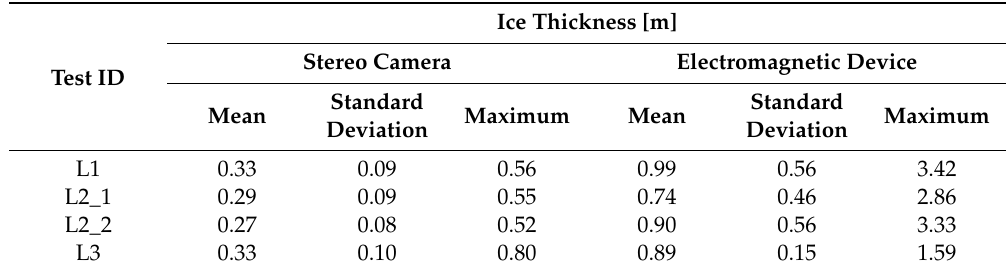
Table 4. Measured ice conditions during the straight-ahead tests.